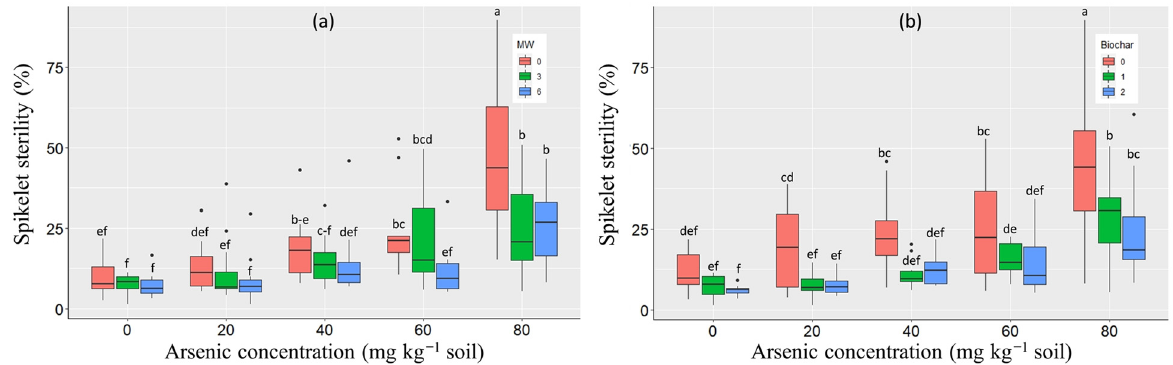
Figure 4. Effect of soil arsenic (As) on spikelet sterility in response to ( a ) microwave (MW) and ( b ) biochar treatments. Replicated mean values are shown in the boxplot. The different letter indicates the significant difference (LSD test at 5% level of significance) among the